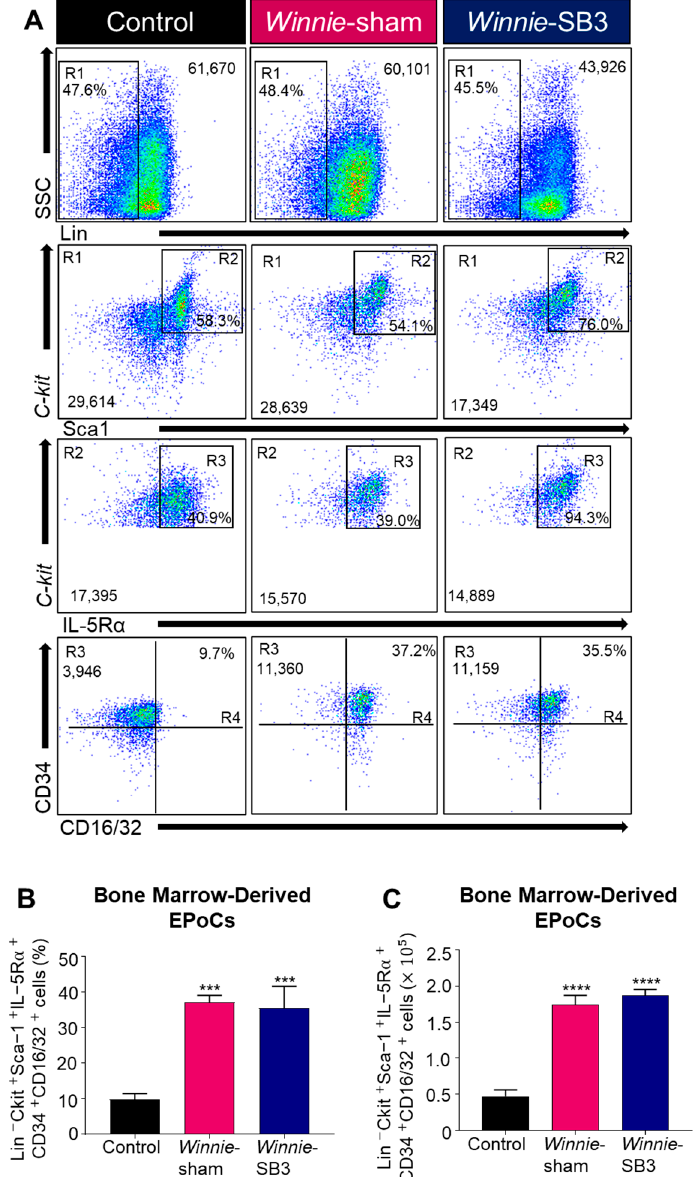
Figure 6. The effects of SB3 treatment on eosinophil progenitor cells (EPoCs) in bone marrow. ( A ) Gating strategy employed on viable cells: (R1) Lin − SSC LO/HI was used to remove mature cell types, with subsequent gating on (R2) C-kit + Sca1 + , (R3) C-kit + IL-5R α + , and (R4) CD34 + CD16/32 + to discriminate EPoCs in the bone marrow. Proportions ( B ) and cell counts ( C ) for the Lin − C-kit + Sca1 + IL- 5R α + CD34 + CD16/32 + EPoCs ( n = 7/group). Data are expressed as mean ± SEM; *** p < 0.001, **** p < 0.0001 compared to control mice.